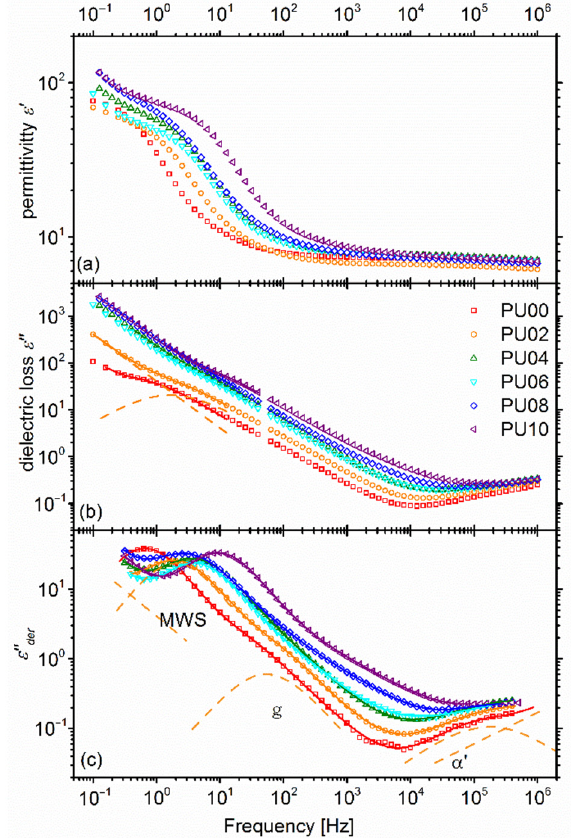
Figure 13. ( a ) Real and ( b ) imaginary parts of the dielectric function at 60 ◦ C for all materials under investigation. ( c ) ε (cid:48)(cid:48) spectra as calculated according to the method described in text. Cntinuous lines are fits according to the procedure described in text. Dashed lines are individual components of the fits for the sample with 2 wt% POSS.